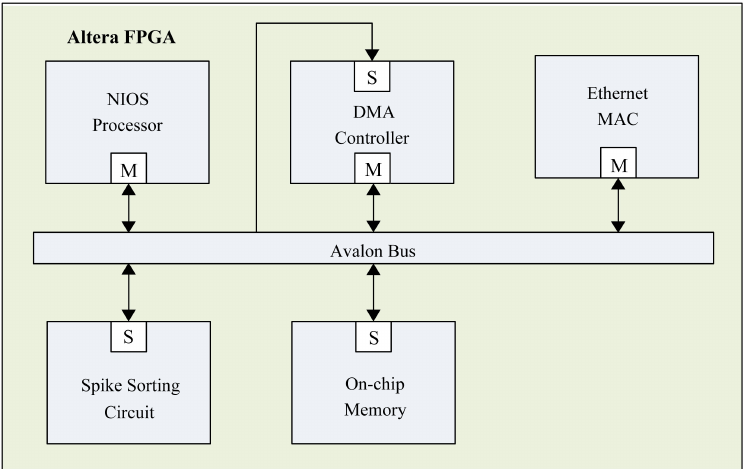
Figure 11. The System-on-Chip (SOC)-based spike sorting system.